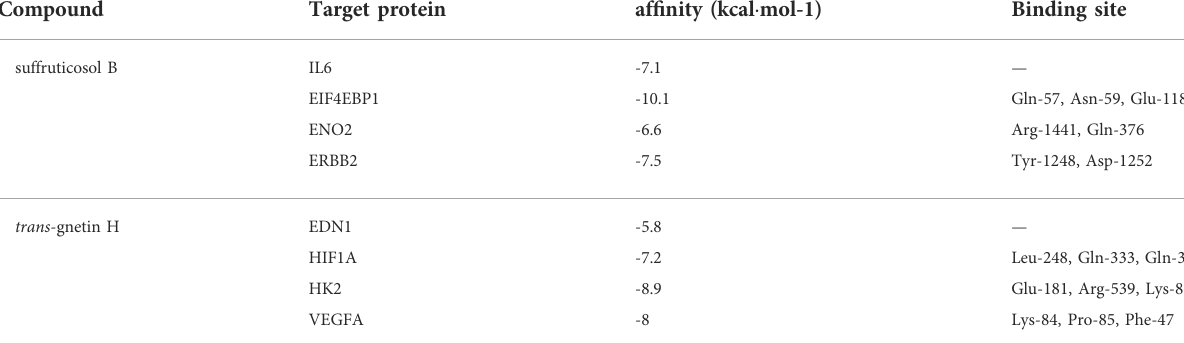
TABLE 2 The molecular docking af fi nity and binding sites of SB and GH with target proteins in HIF-1 signaling pathway.